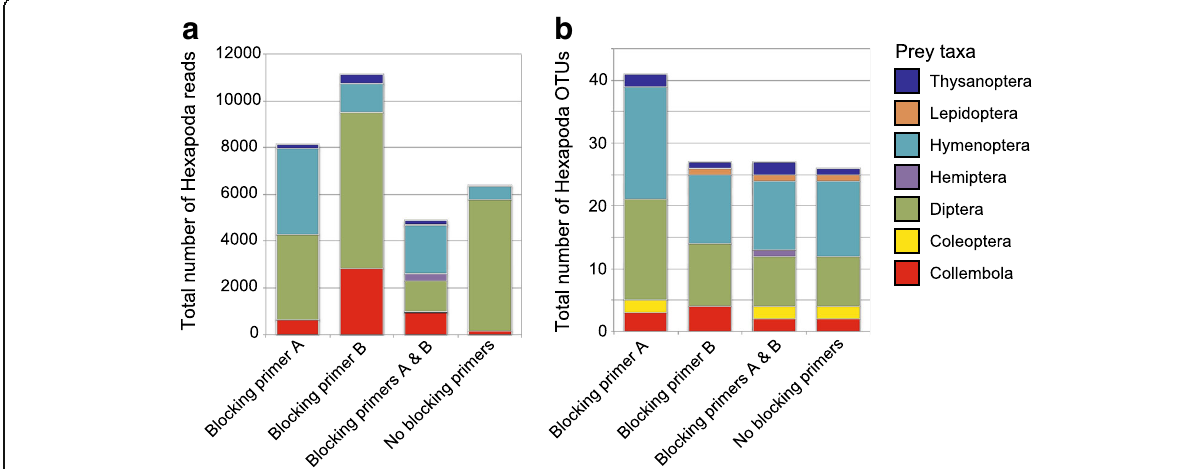
Fig. 3 Taxonomic composition of obtained Hexapoda reads and OTUs. a Taxonomic composition of Hexapoda sequencing reads in the four PCR settings. b Taxonomic composition of Hexapoda OTUs in the four PCR